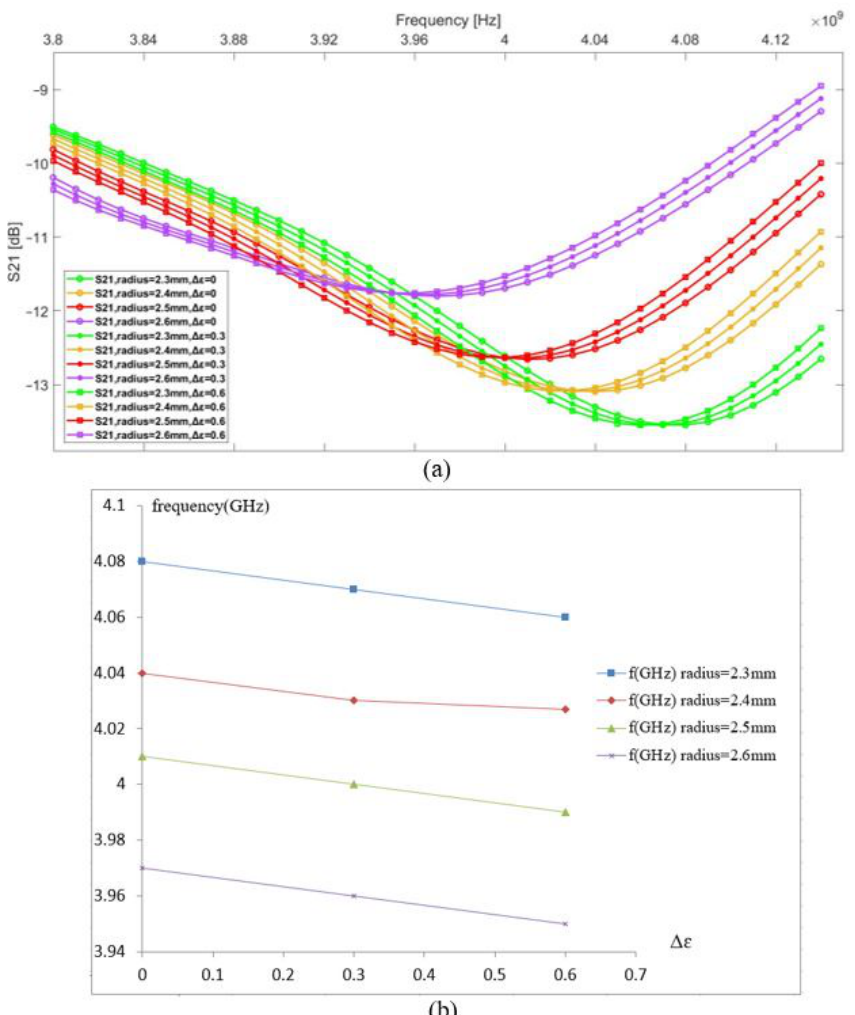
Figure 5. ( a ) S21 vs. frequency, ( b ) resonance frequency shift vs. permittivity change in the